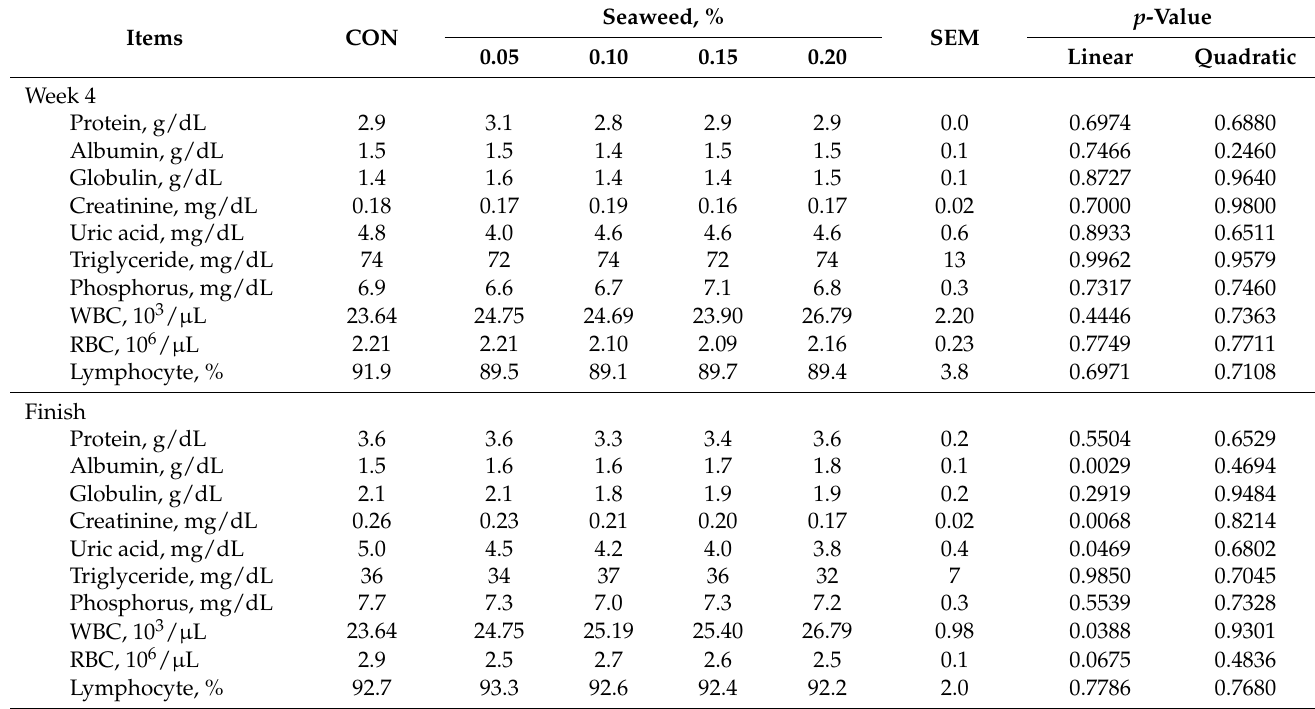
Table 4. The effect of red seaweed supplementation on blood profiles in broilers 1